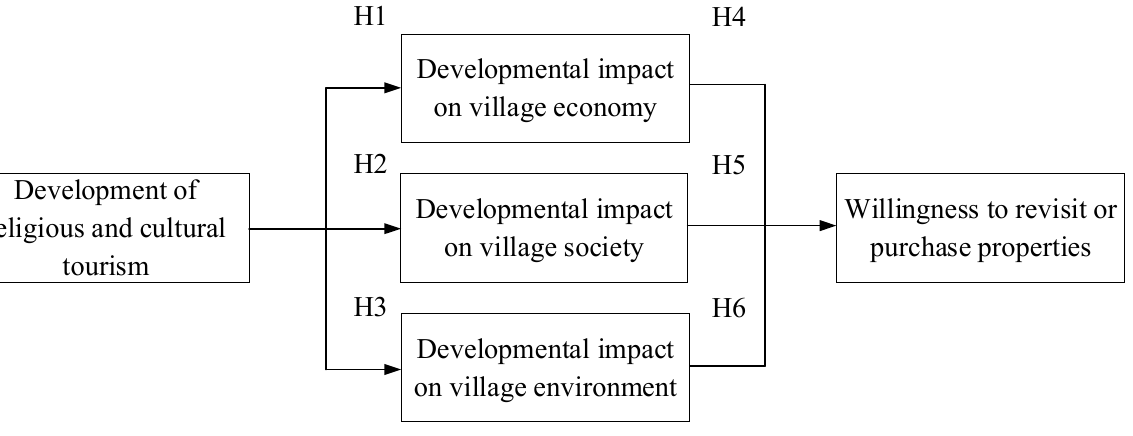
Figure 1. Study framework.